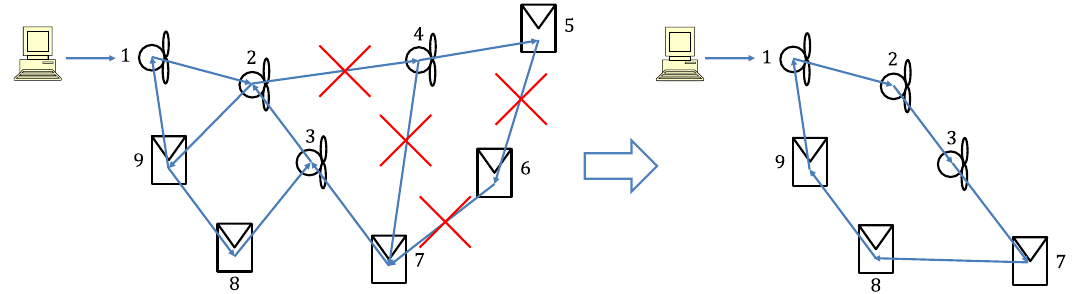
Figure 29. Operation of distributed PV and wind system under CIC.